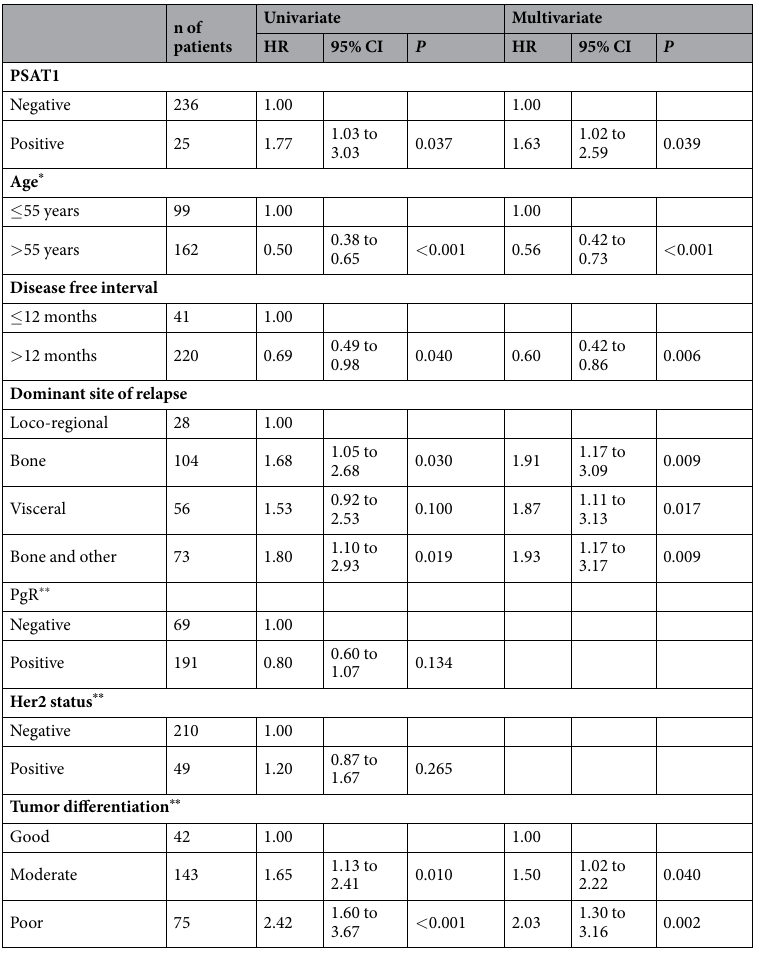
Table 2. Cox regression analysis for TTP of PSAT1 stained tumors. * Age was assessed at start of tamoxifen therapy. ** Missing data not